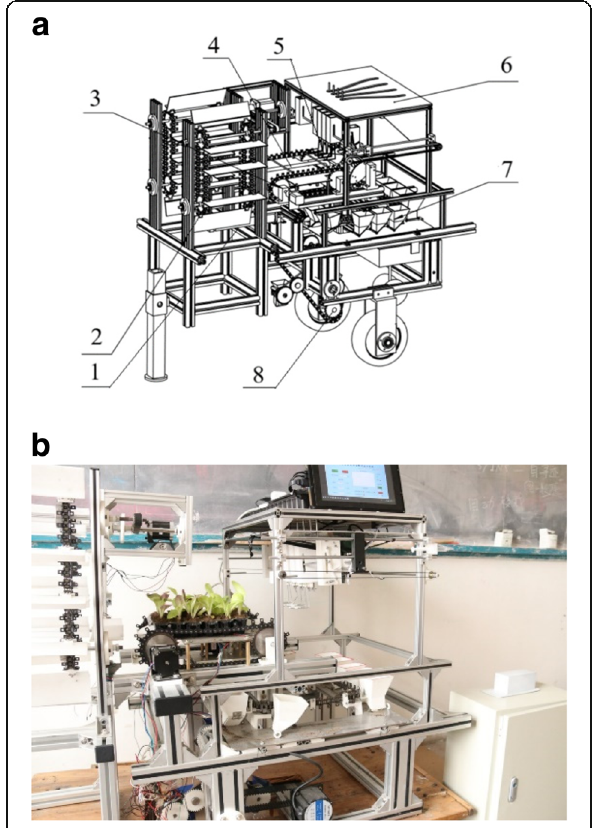
Fig. 1 Automatic conveying device for vegetable seedlings. a Structure diagram. 1 Pushing mechanism, 2 seedling storage plate, 3 seedling tray conveyor motor, 4 seedling tray conveyor belt, 5 bowl seedling ejection mechanism, 6 rowed clamp seedling-taking mechanism, 7 drive motor of cup conveying mechanism. b Diagram of